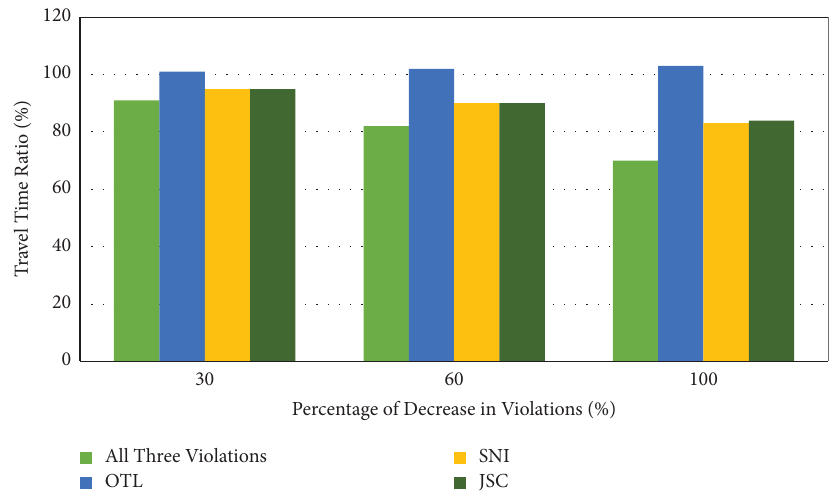
Figure 13: Travel time ratio versus percentage of decrease in